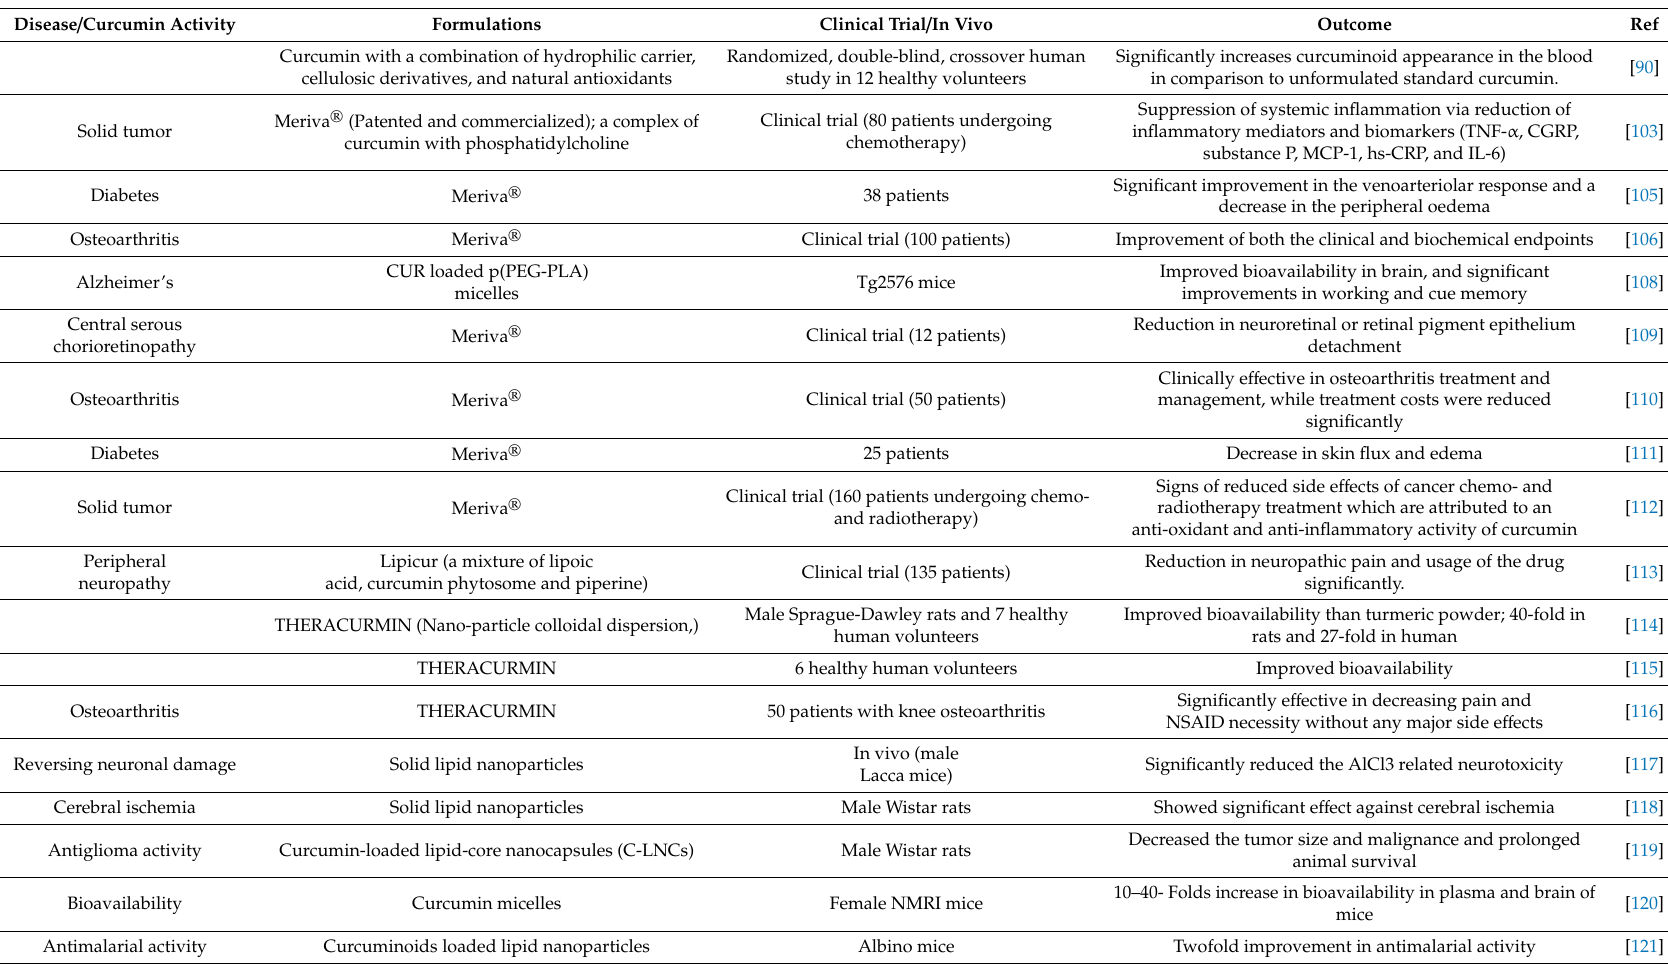
Table 1. Several curcumin formulations and their clinical or in-vivo